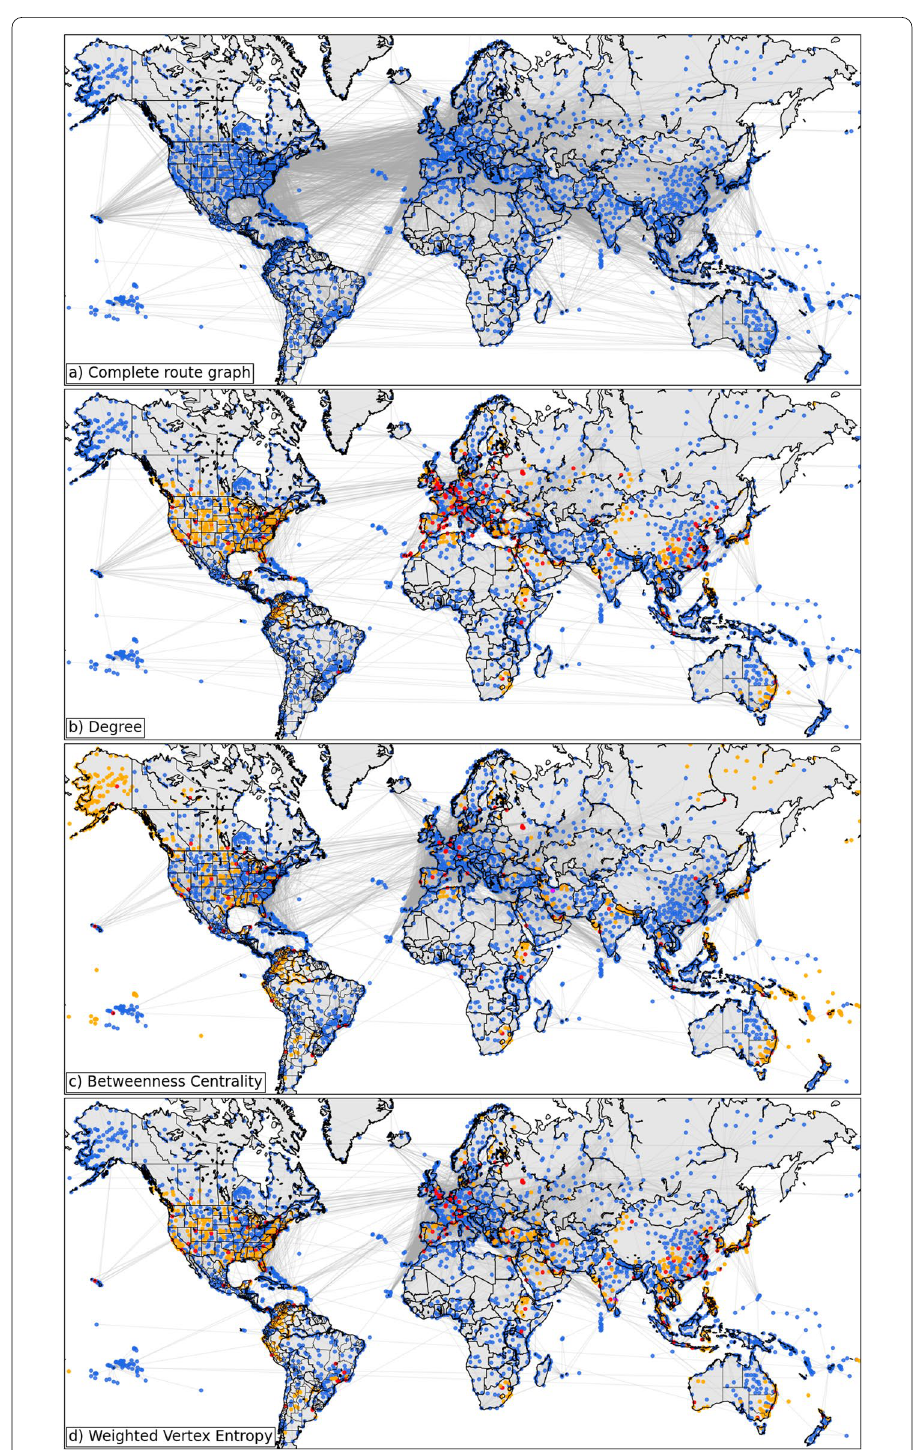
Fig. 2 The global airline route maps under different network dismantling regimes. a Shows the complete graph with no nodes removed. b – d Show the route graph when the GC has been reduced to 80% of its original size using degree, betweenness centrality and weighted vertex entropy respectively. Open airports are represented by blue dots, removed airports by red dots and disconnected airports by orange dots. A high resolution version of this figure is available at https:// doi. org/ 10. 6084/ m9. figsh are. 14994